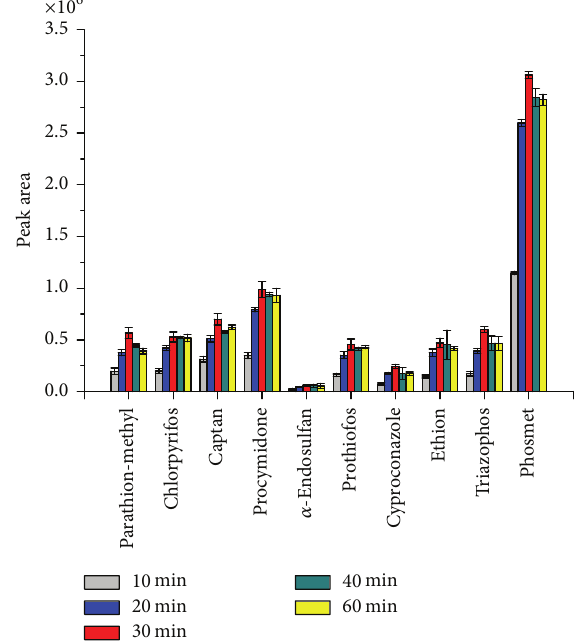
Figure 4: Effect exposure times on the extraction efficiency. Extrac- tion conditions of the donor phase: 15.0 mL of water spiked at 100.0 𝜇 gL −1 of each pesticide; stirring speed of 200 rpm; and ethyl octanoate in the acceptor phase. Error bars represented the standard deviation of the mean peak area for 𝑛 = 3 replicates.